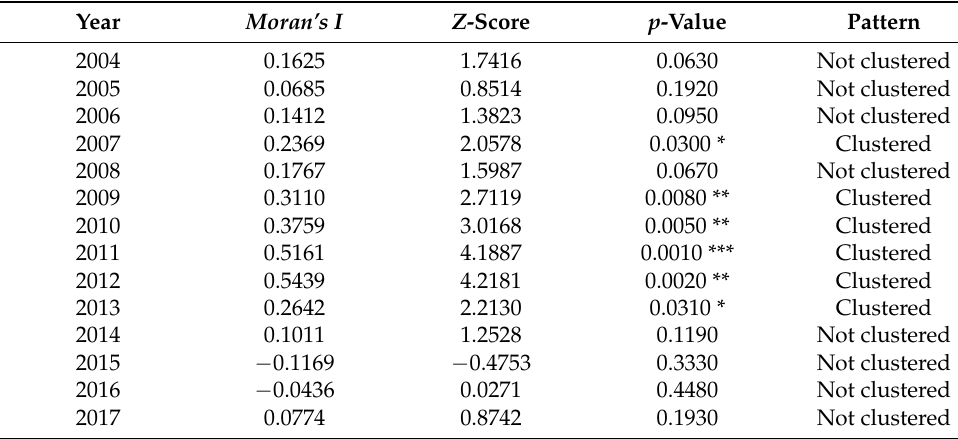
Table 2. Global Moran’s I of syphilis SMR in Ningxia,